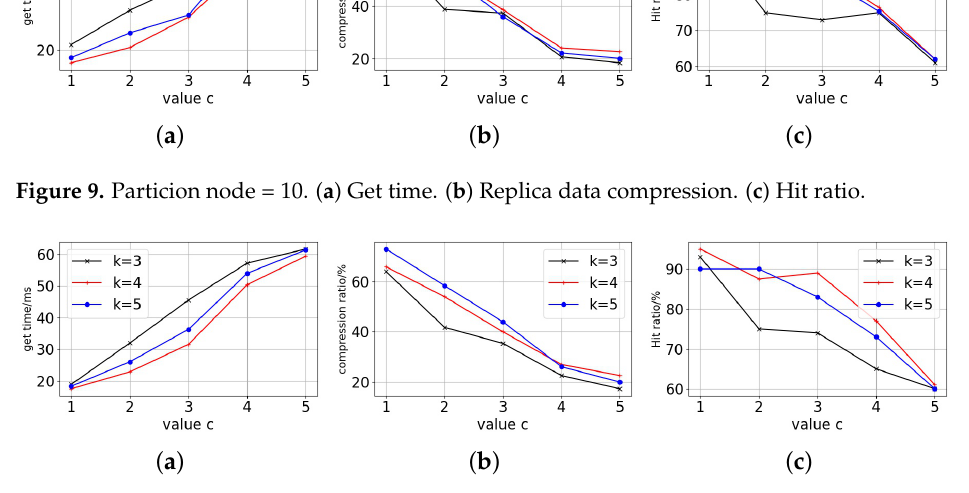
Figure 10. Particion node = 50. ( a ) Get time. ( b ) Replica data compression. ( c ) Hit ratio.